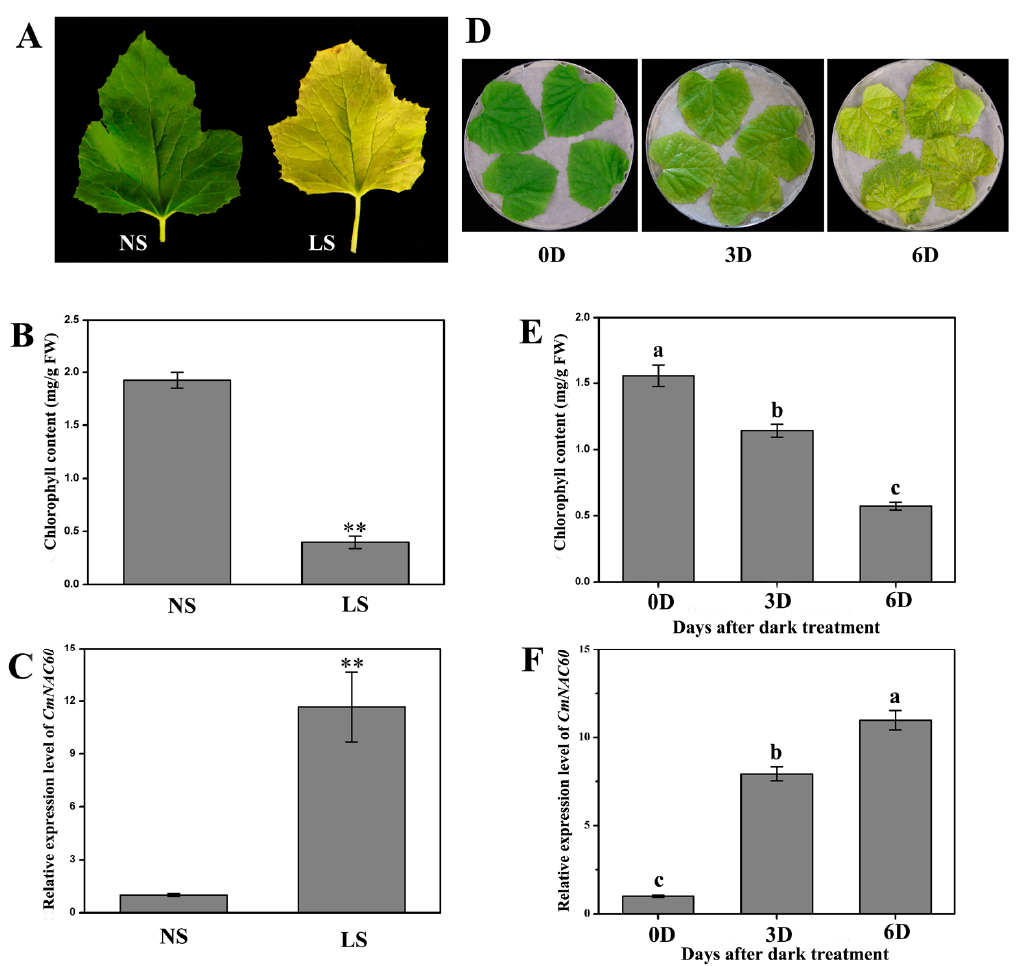
Figure 3. Chlorophyll contents and relative expression levels of CmNAC60 in oriental melon leaves during natural senescence and dark treatment. ( A ) Oriental melon leaves at non-senescing and naturally senescing stages. NS—a fully expanded and non-senescent leaf; LS—a late senescence leaf. Chlorophyll contents ( B ) and relative expression levels of CmNAC60 ( C ) at two stages of natural senescence. ( D ) The detached leaves of oriental melon treated in the dark for zero, three, and six days. Chlorophyll contents ( E ) and relative expression levels of CmNAC60 ( F ) at different dark treatment times. Data are mean ± SD from three biological replicates. The experiments were independently repeated three times with 12 leaves each time. Asterisks indicate statistically significant differences compared with NS (** p < 0.01). Different lowercase letters indicate statistically significant differences at p < 0.05. Bars indicate standard deviation.